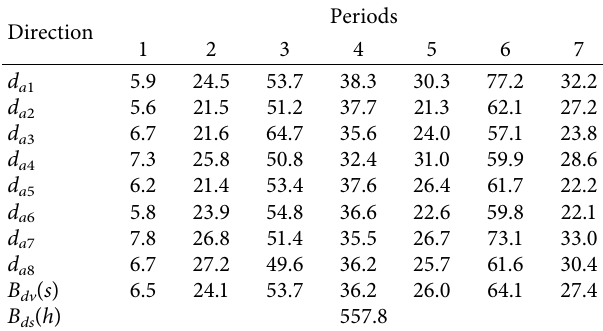
Table 9: Analysis results of the average vehicle delay in scheme B.